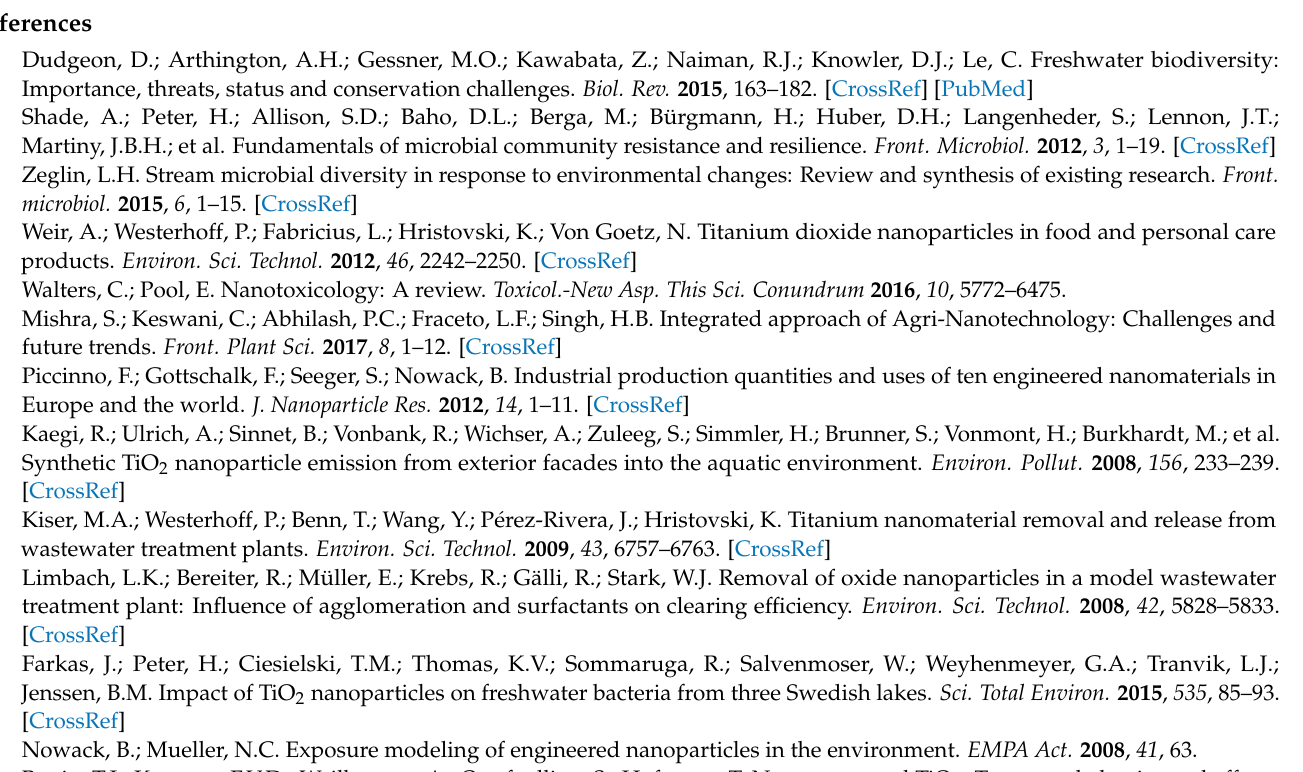
area under the curve value, Figure S2: The effect of TiO 2 nanoparticles on Shannon evenness value of freshwater, Figure S3: The effect of TiO 2 nanoparticles on freshwater Simpson index value, Figure S4: The effect of TiO 2 nanoparticles on freshwater Gini index value, Table S1: Pearson correlation results to evaluate coherence of nZnO concentrations and diversity indices, Table S2. Pearson correlation results to evaluate coherence of nTiO 2 concentrations and diversity